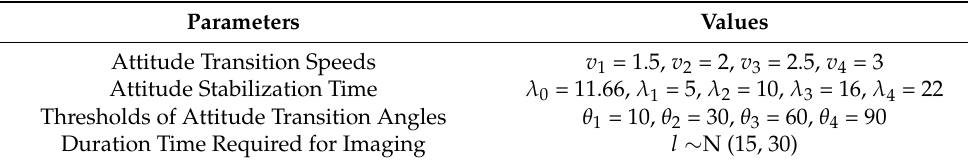
Table 1. Attitude transition and task